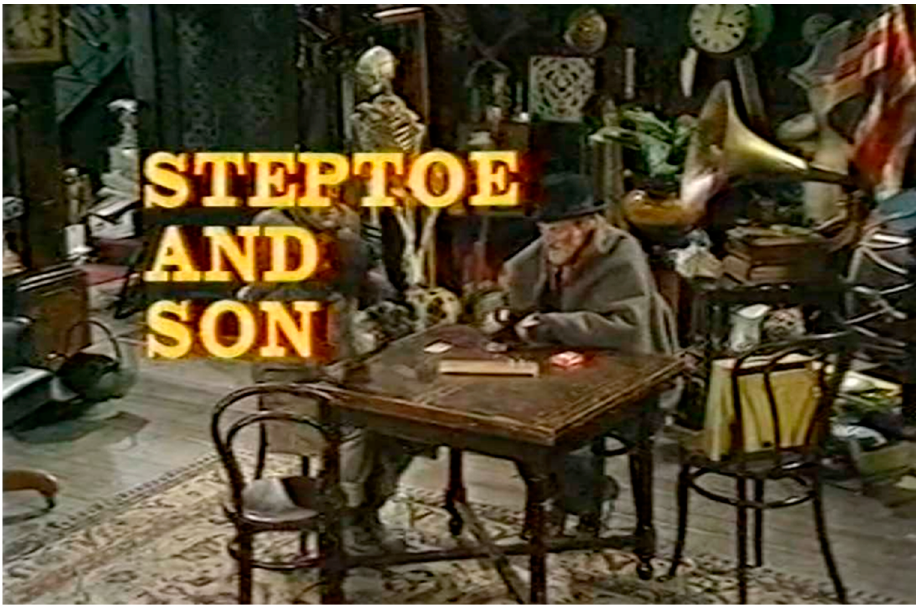
Figure 1. The Steptoes in their shabby home, with accumulated